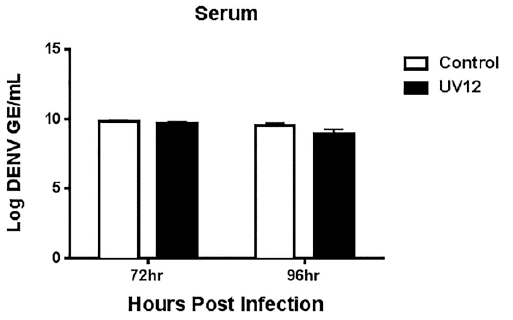
Figure 5. Dengue viral titer determined using qRT-PCR in serum or tissues collected from UV-12 treated AG129 mice. Groups of AG129 mice received the first treatment dose of 100 mg/kg of UV-12 or vehicle control 1 h before infection with DENV2 at a dose of ~1LD 90 . Treatment continued three times daily at 8 h intervals until tissue harvest at 72 or 92 h post infection. Viral titers in the serum or liver, spleen, kidney and small intestines were determined by qRT-PCR for each sample from individual animals and the mean with standard deviation are also shown for each group. Data are shown as log DENV genome equivalents per mL of serum or as log DENV genome equivalents per relative 18S (× 10 4 ) for the tissues analyzed. Statistical differences ( p < 0.05) are indicated with the actual values over the relevant data